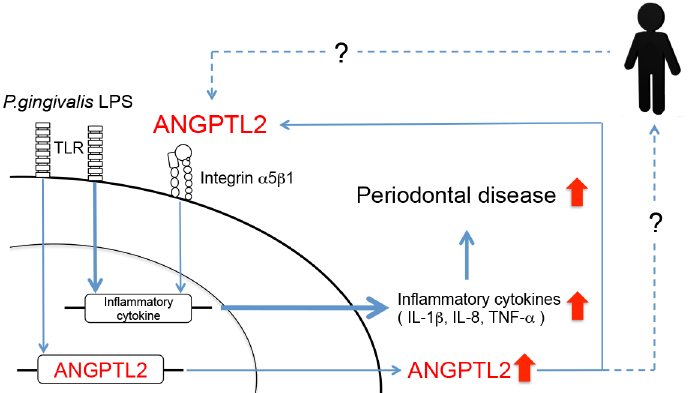
Fig 7. Diagram summarizing the possible mechanisms responsible for ANGPTL2 function in human gingival epithelial cells. We identified a novel signalingcascade comprisingsequential P . gingivalis LPS stimulation ! ANGPTL2 induction ! integrin α 5 β 1 ! inflammatory cytokine induction, which results in potent periodontaldisorganization activity in gingivalepithelialcells. The bold line is generallyconsidered as the main pathway mediatinginflammatory cytokine productionby periodontalpathogenssuch as P . gingivalis LPS. Non-bold line is shown as a novel signalingpathway via ANGPTL2 in P . gingivalis LPS stimulation.The dashedline is based on a hypothesisthat ANGPTL2 is one of key mediatorbetweenperiodontaldisease and systemic disease.